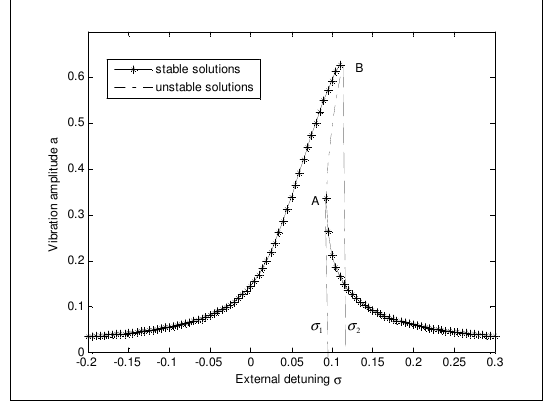
Figure 1. Typical frequency-response curve of the primary reso- nance response for certain forcing amplitude larger than its critical value. Solid lines denote stable solutions and dash-dot lines represent unstable